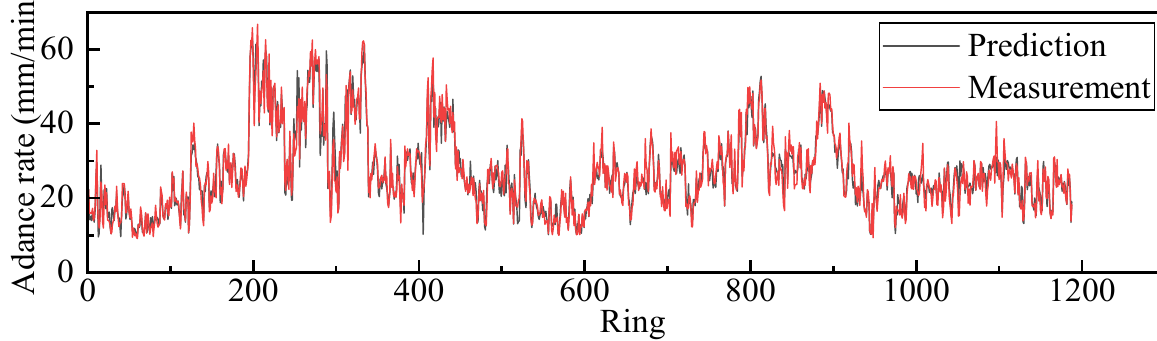
Figure 12. Performance of BPNN on all data.